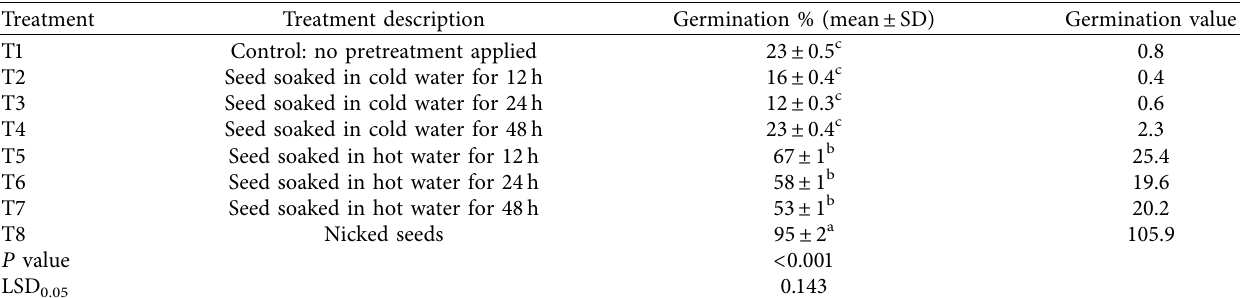
Table 2: Treatment method, germination percentage, and germination value of S. spectabilis , 28 days after seed sowing. Treatment